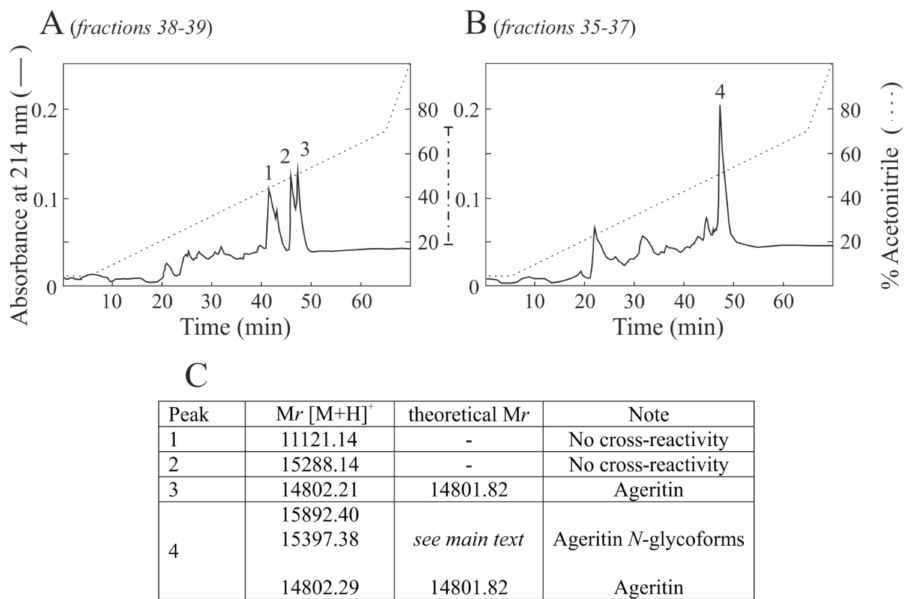
Figure5. RP-HPLCseparationof38–39( A )and35–37( B )crossreactivefractionsobtainedaftergel-filtration separation of basic proteins extracted from A. aegerita mycelium. In ( C ), relative molecular mass (M r ) of peaks containing cross-reactive electrophoretic bands using the rabbit antiserum against Ageritin. The average molecular masses values obtained by MALDI-TOF MS are reported as [M + H + ] +